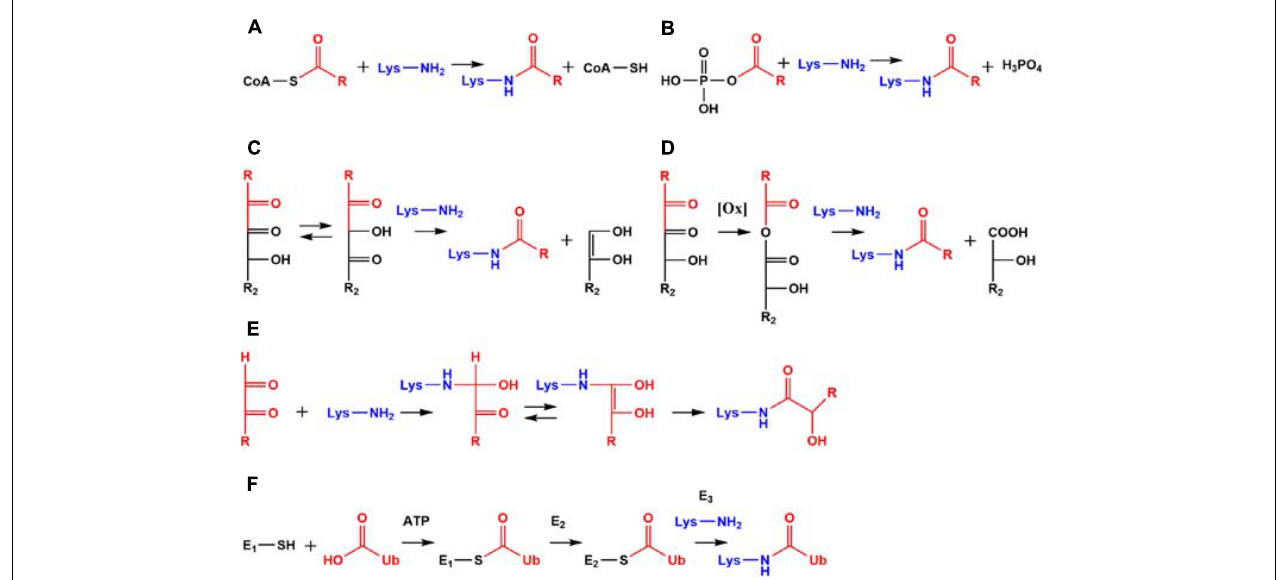
FIGURE 2 | Comparison of non-enzymatic acylation mechanisms and ubiquitylation. Reactive species like acyl-CoA thioesters (A) and acyl phosphates (B) modify lysine residues non-enzymatically leading to protein modifications with an amide structure. Amide AGEs are formed by α -dicarbonyls via amine induced β -dicarbonyl fragmentation (C) , oxidative α -dicarbonyl fragmentation (D) , and isomerization (E) . Ubiquitin (Ub) is activated as a thioester by ubiquitin-activating enzyme (E1) under consumption of adenosine triphosphate (ATP). Activated Ub is transferred to an active site cysteine of ubiquitin-conjugating-enzymes (E2s). The high energy of